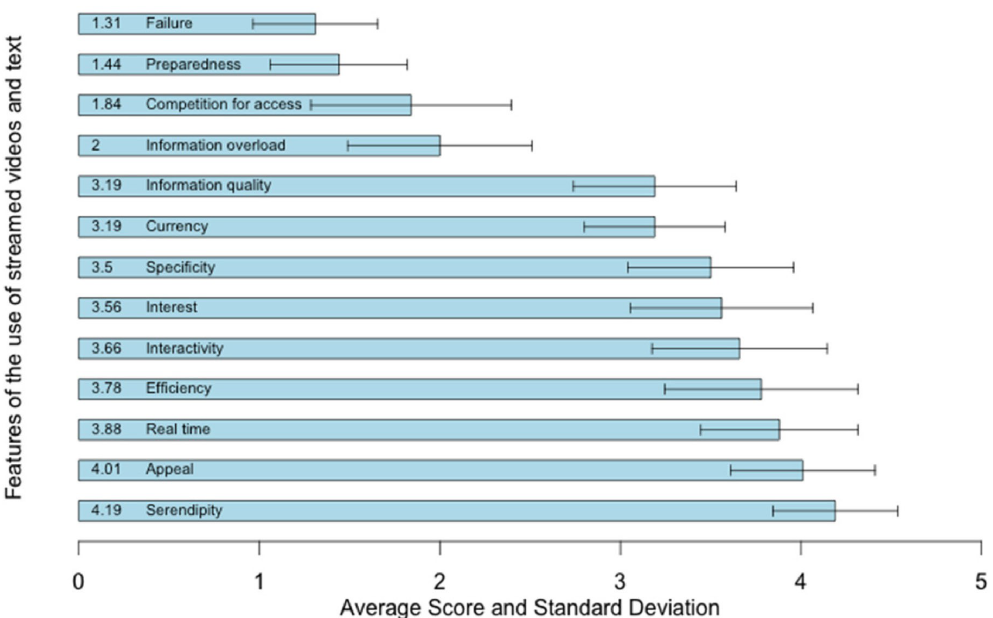
Figure 1. Second set of features and their